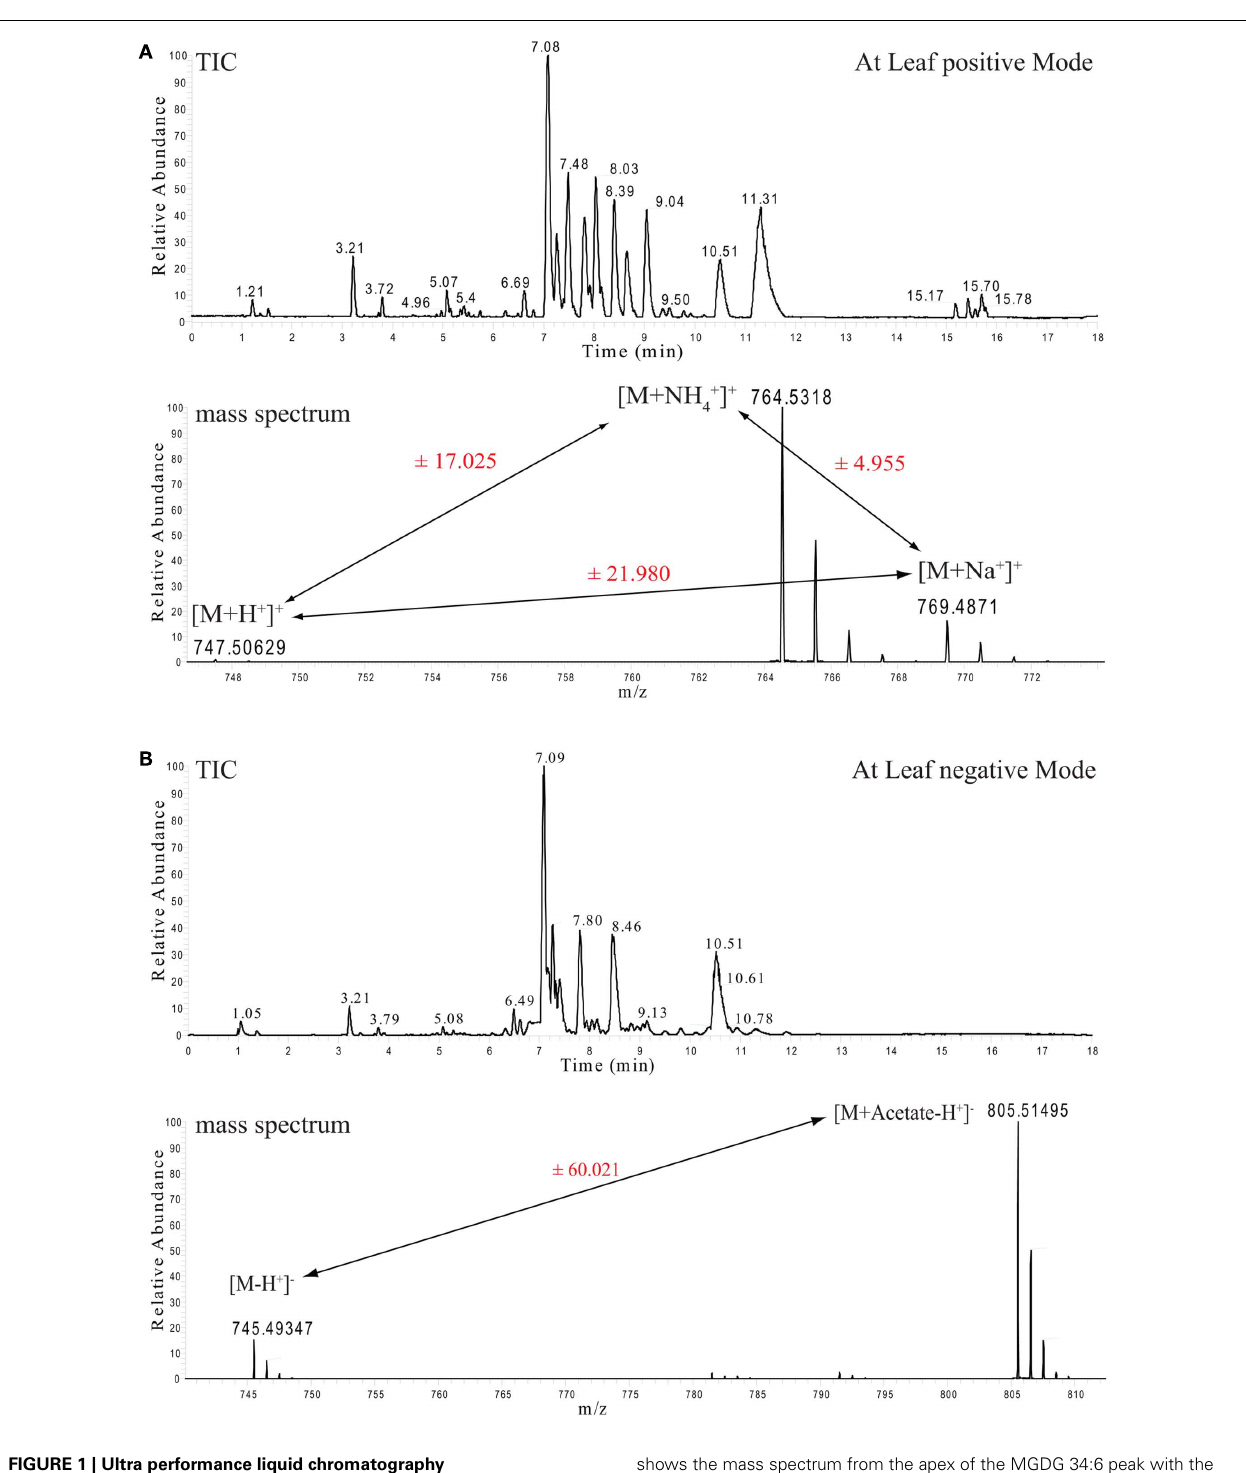
shows the mass spectrum from the apex of the MGDG 34:6 peak with the retention time of 7.08min and its associated ionization adducts. (B) As above, but here theTIC and the spectrum of the negative ion mode measurements are shown.